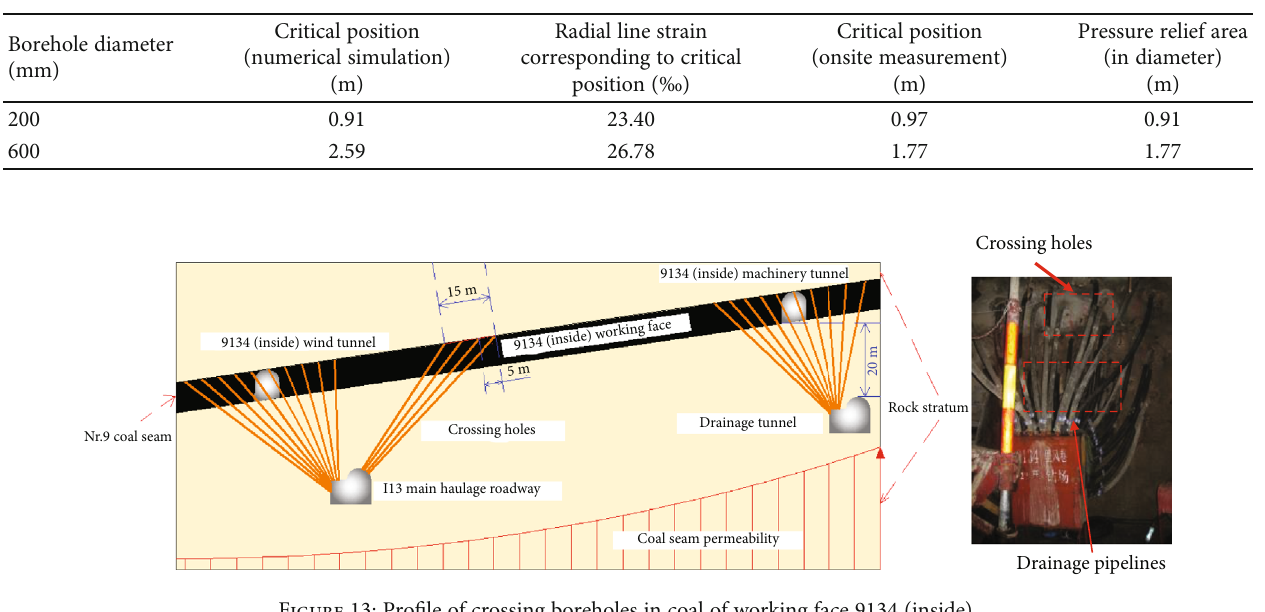
Table 3: Drilling e ff ective radius of pressure relief.